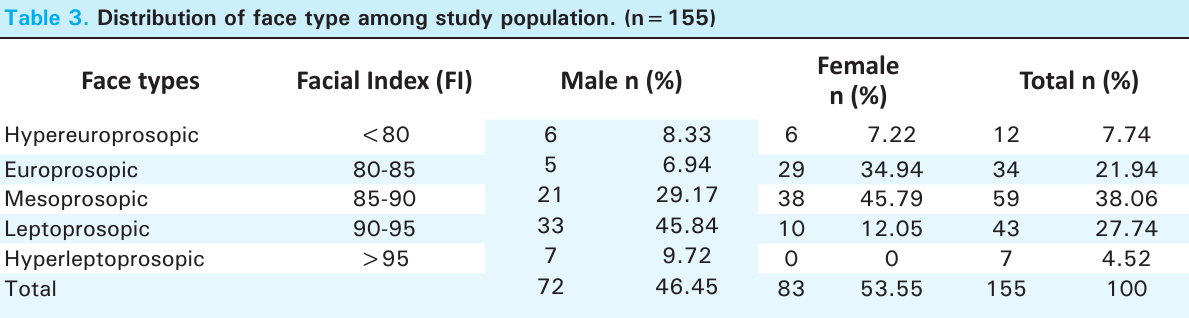
Table 3. Distribution of face type among study population. (n=155) Face